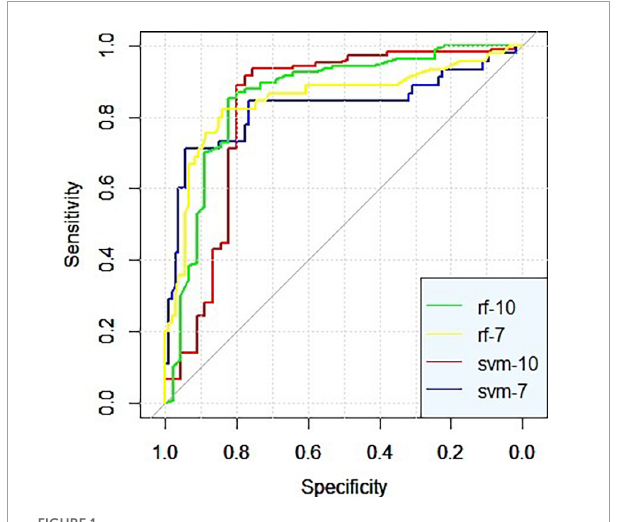
FIGURE1 ROC curves of the